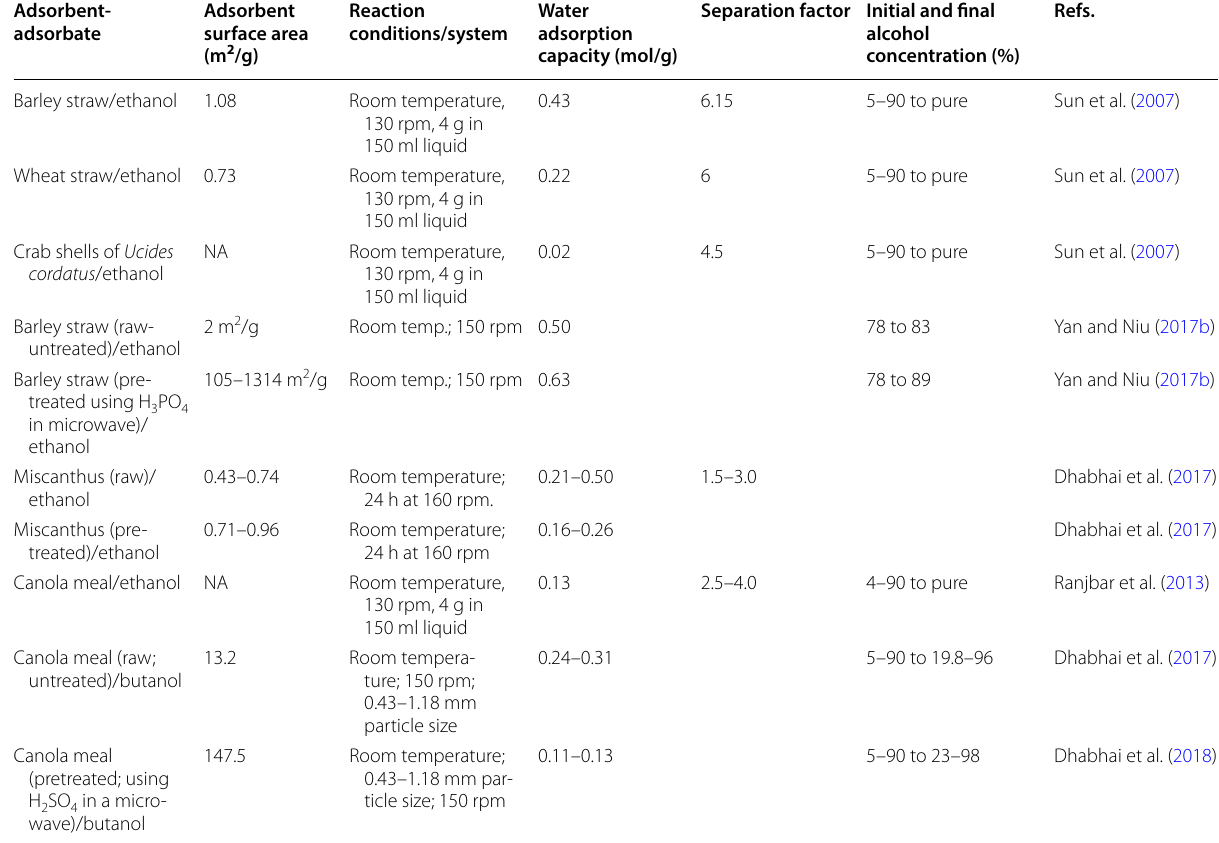
Table 5 Biobased sorbents for liquid phase drying of ethanol and butanol Adsorbent-